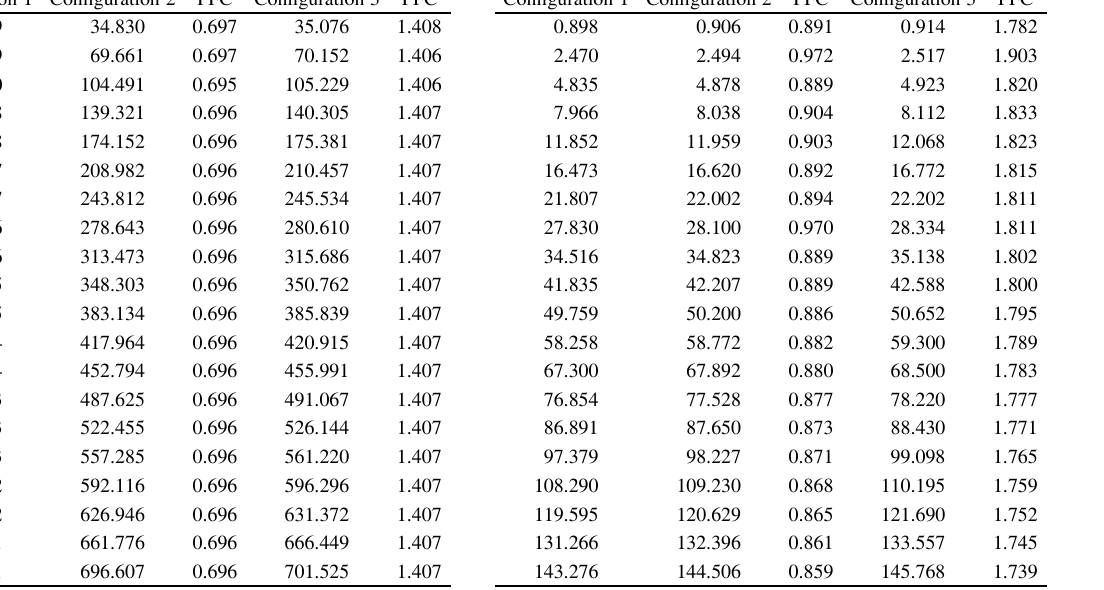
Longitudinalnaturalfrequenciesofaradartrussfor t L = t b = t d = 4.8 × 10 − 4 m and L tot = 300 m in (rad/sec) Con fi guration 1 Con fi guration 2 PFC Con fi guration 3